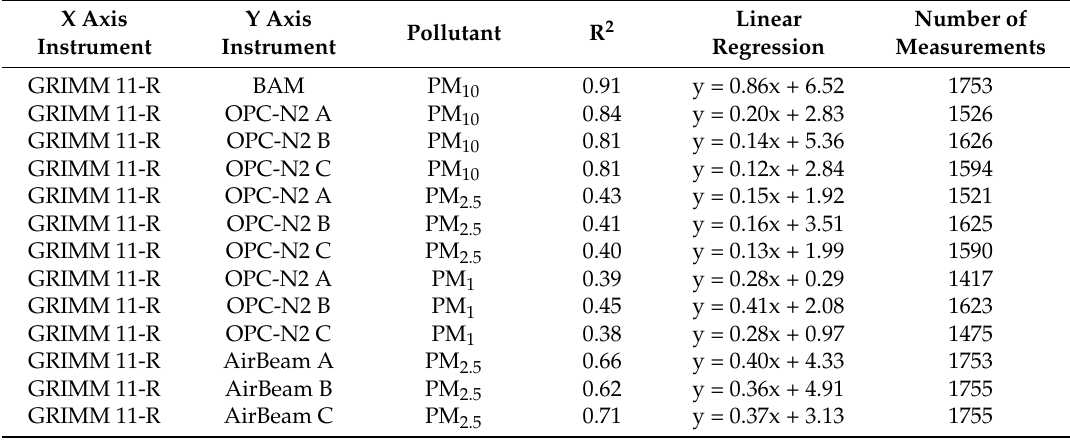
Table 4. Correlation and linear regression of GRIMM 11-R versus sensor and BAM PM measurements. X Axis Instrument